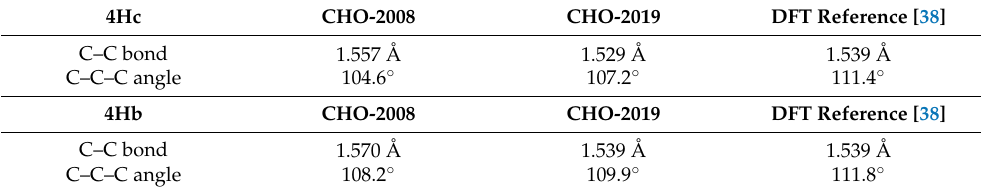
Table 3. C–C bonds and C–C–C angles for different configurations of double-sided hydrogenation.